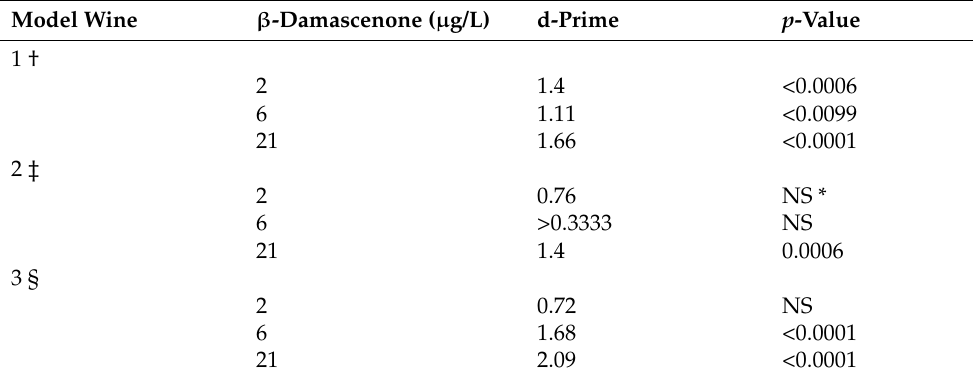
Table 2. Significance of β -damascenone concentration on Pinot noir wine aroma using signal detec- tion